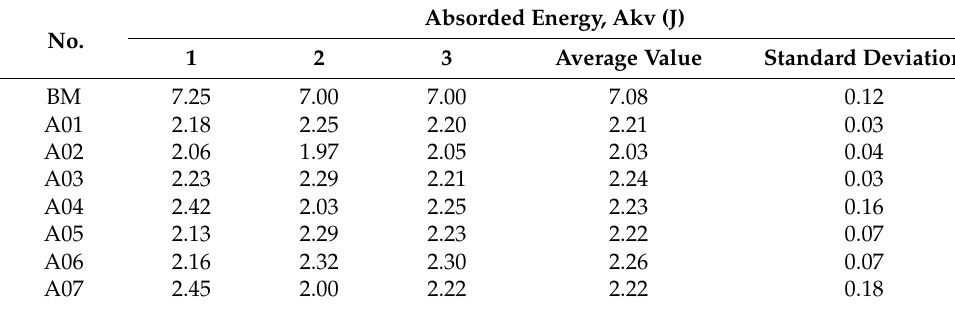
Table 5. Absorbed energy results of the base metal and specimens